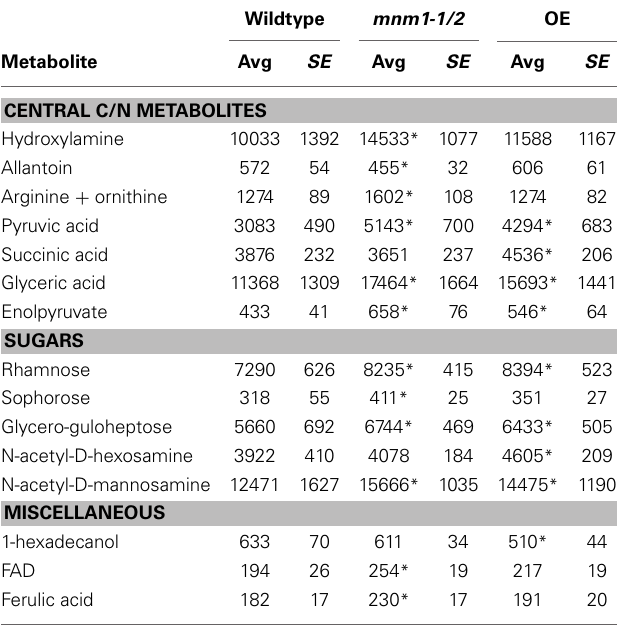
Table 1 | Known metabolites altered at mid-day by MNM1